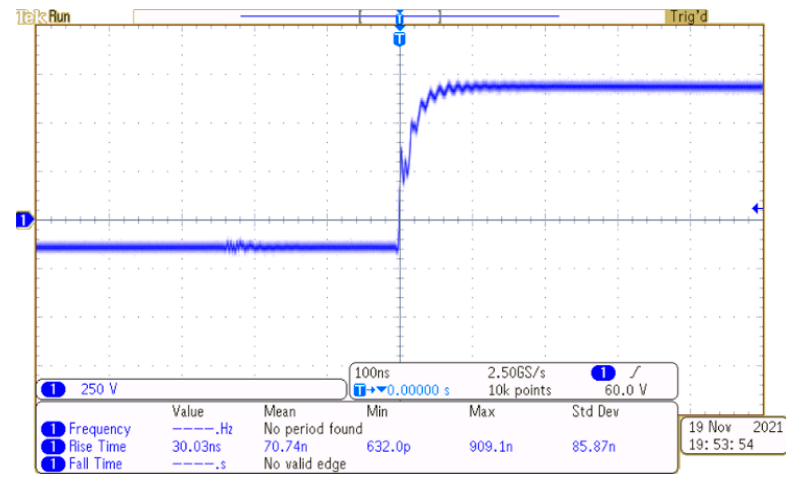
Figure 10. Gate—source voltage rise time for transistor SiC v1 (30 ns).